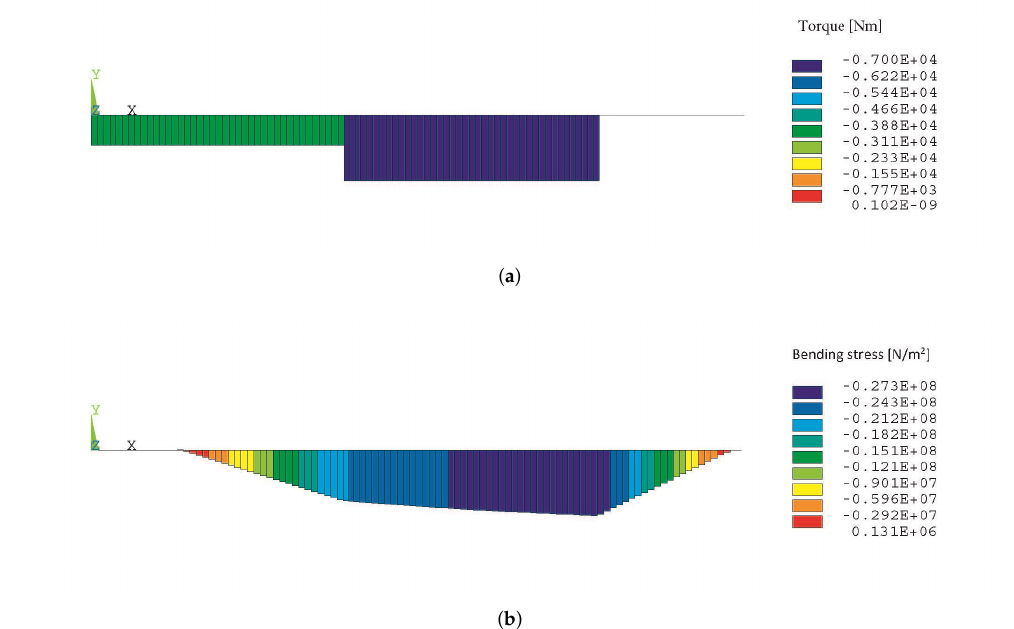
Figure 10. ( a ) Torque diagram and ( b ) bending stress diagram at the top of the